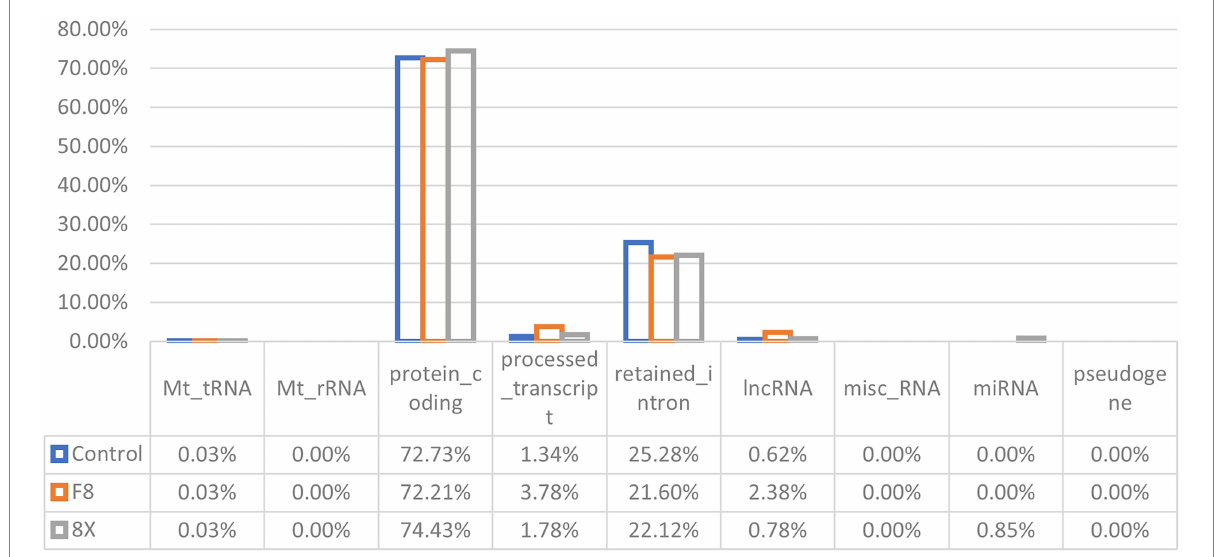
FIGURE 1 RNA categories of quantified transcripts in RNA-seq. The percentages of each RNA type are shown in F8/8X infected or mock-infected Calu-3